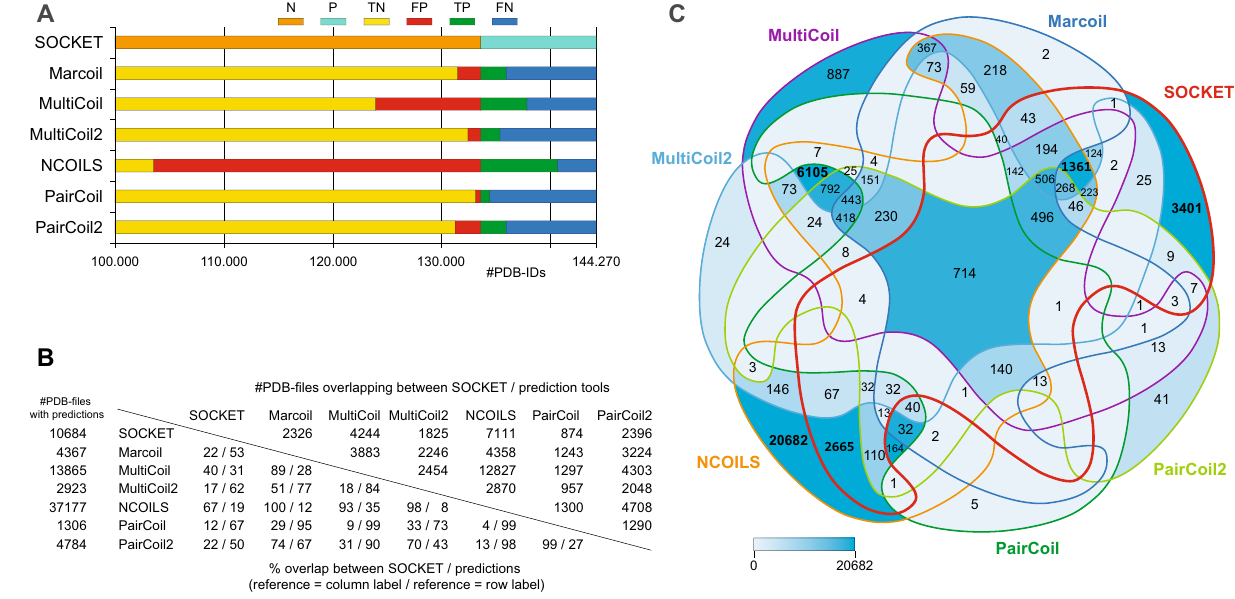
Figure 1. Coiled-coil regions identified by SOCKET and predicted with the respective tools at the level of PDB files. ( A ) Of the 144,270 PDB files 10,684 contain a coiled coil according to SOCKET (P = positives; the remaining 133,586 PDB files represent the negatives = N). Based on the overlap with these SOCKET hits, the coiled-coil predictions of the tools were categorized into four classes: true positives (TP = predictions in same PDB files as SOCKET hits), false positives (FP = predicted coiled coils in PDB files where SOCKET did not detect any), true negatives (TN = no prediction and no SOCKET hit in PDB files), and false negatives (FN = no prediction in PDB file in which SOCKET identified a coiled coil). ( B ) The tools predicted coiled coils in 1307 (PairCoil) to 37,177 PDB files (NCOILS; left column). The numbers in the matrix denote the overlap between SOCKET and every tool, and between any two tools, at the level of hits within the same PDB file (upper part: total numbers; lower triangle: percentage overlap with respect to SOCKET or tool). ( C ) The 7-way Venn diagram shows the subsets of PDB files with SOCKET hits and predicted coiled coils found by the respective combinations of tools colored by number in intersection. The intersection of PDB files with coiled coils predicted by all tools is 714 PDB files, and 1210 PDB files when ignoring PairCoil, the tool with the least